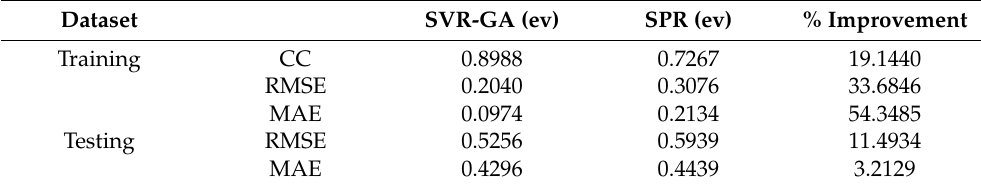
Table 3. Computed performance of the developed model using evaluation parameters.